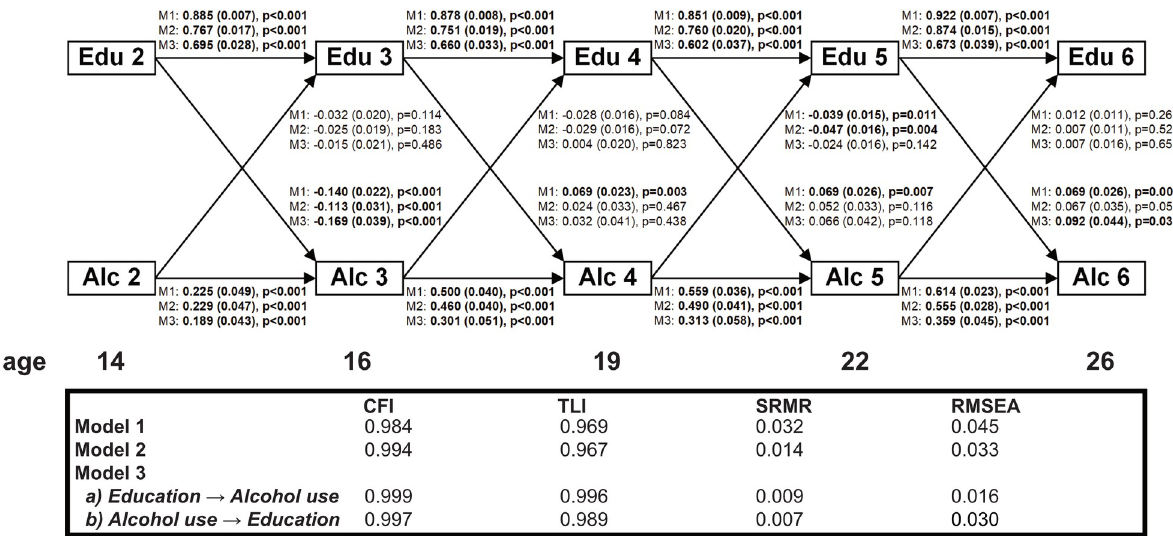
Fig 2. Bidirectional associations between educational level and alcohol use in the TRAILS Study (the Netherlands, 2000–2017, N = 2,229); linear regression coefficients (stdyx-standardized ß-coefficient, robust standard error, p-value) from cross-lagged panel models without (Model 1 and 2) and with fixed effects (Model 3). Model 1: bivariate cross-lagged panel model. Model 2: cross-lagged panel model adjusted for age, gender, area of residence, ethnicity, parental socioeconomic status, IQ, and effortful control at baseline (wave 1). Model 3: cross-lagged panel models with fixed effects–adjustment for time-invariant characteristics was performed by inclusion of a latent variable. Edu = educational level; Alc = alcohol use. Boldface denotes statistical significance at p < 0.05.